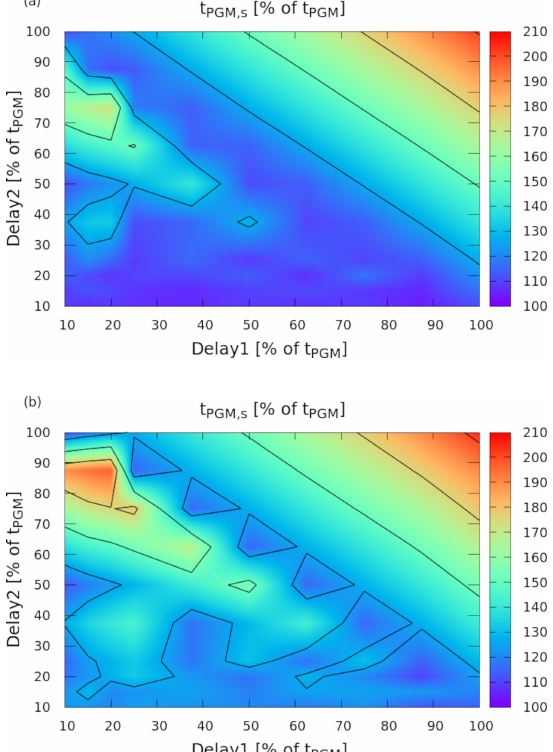
Figure 8. ( a ) The average of the overall programming time t PGM , s . ( b ) The worst t PGM , s extracted from the 50 wordlines involved in the experiment. Both measurements are plotted as a function of different Delay1 and Delay2